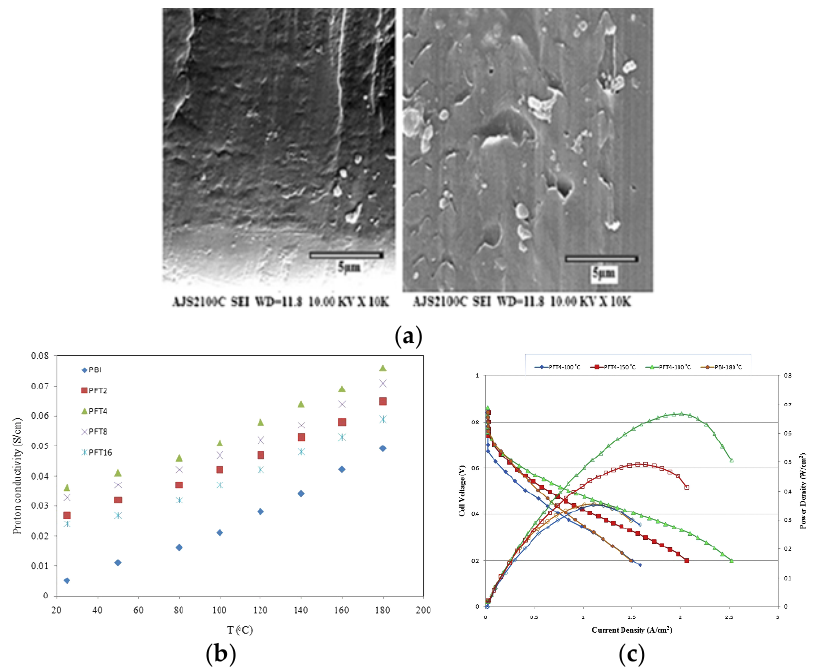
Figure 13. SEM cross-section image of H 3 PO 4 -doped PBI nanocomposite membrane with 4 wt.% and 16 wt.% Fe 2 TiO 5 nanoparticles ( a ); proton conductivity at RH = 0% ( b ); polarization curves for the single PEMFC of H 3 PO 4 -doped PBI with 4 wt.% Fe 2 TiO 5 nanocomposite membrane ( c ). Reprinted with permission from Ref. [108]. Copyright 2016